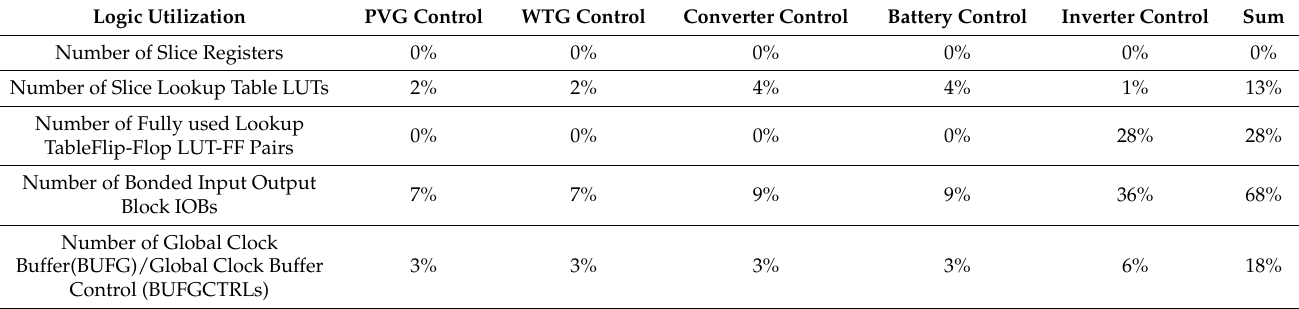
Table 4. Device utilization summary of the synthesis report for different control strategies.